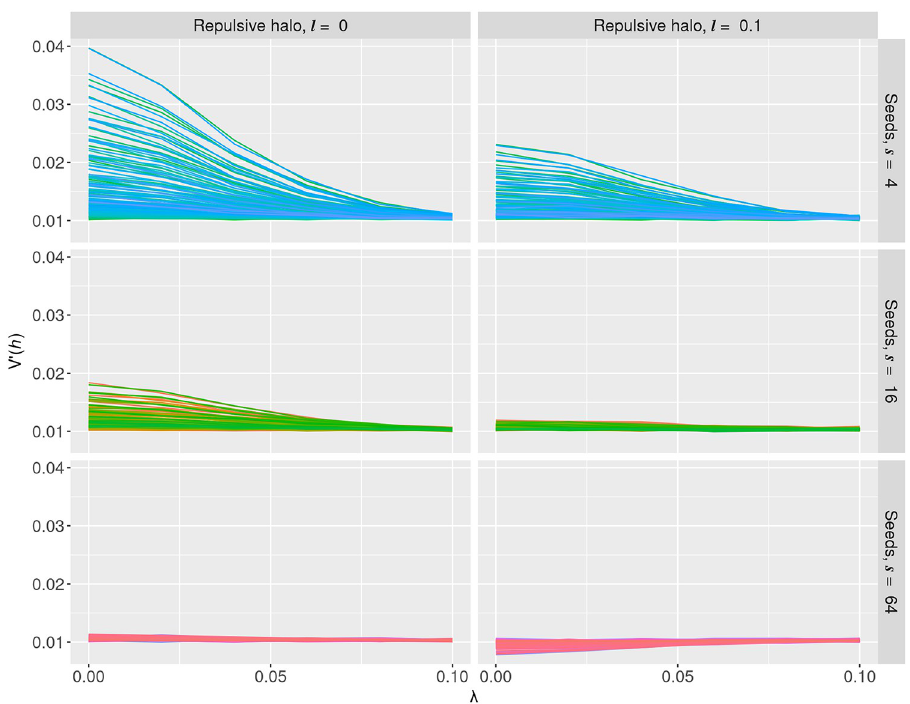
Fig 5. Network fragmentation and diffusion reverse the variance induced by mitochondrial networks. Normalised heteroplasmy variance V 0 ( h ) after repeatedly perturbing each mtDNA molecule with mean displacement λ from their original positions, resulting in a total mean displacement of around 10 λ . The left column shows V 0 ( h ) for random spread of mtDNA in the network (i.e., with a repulsive radius of l = 0); the right column shows V 0 ( h ) for active spread of mtDNA in the network with a radius of l = 0.1. The three rows show decreasing levels of network heterogeneity, expressed via different seed numbers (more seed points give a more homogeneous network). As the diffusion strength increases, effects on cell statistics due to the network is washed away regardless of the underlying mtDNA distribution